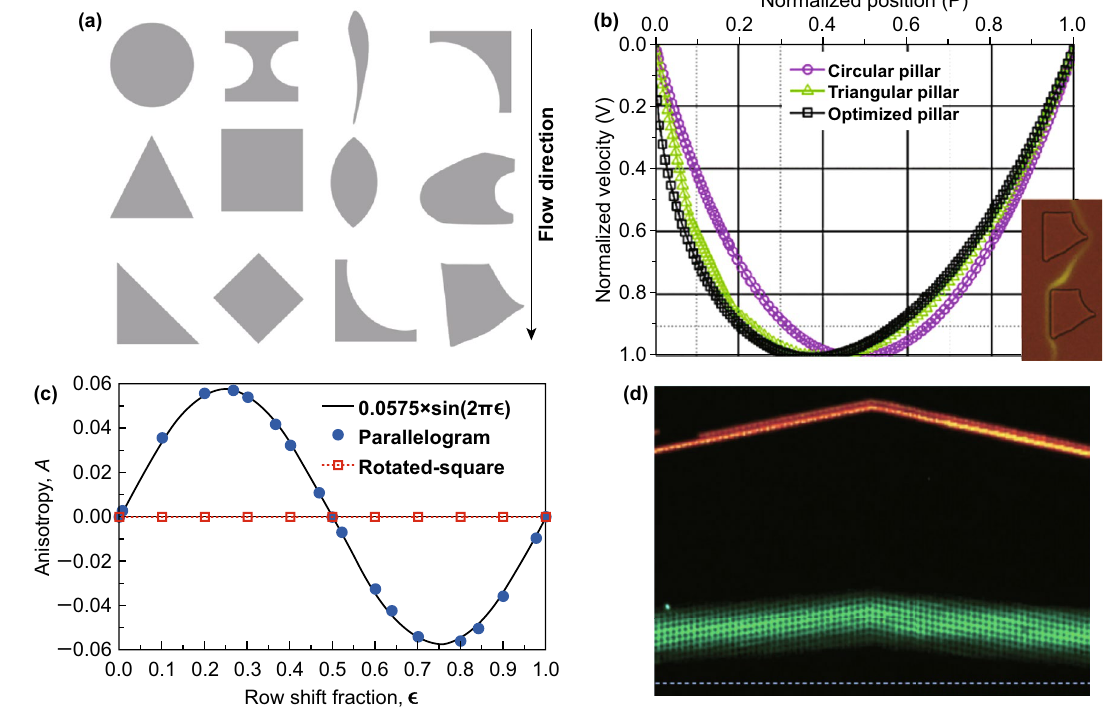
Fig. 5 Geometry-induced effects on critical diameter. a Various DLD pillar shape designs. b The effect of the optimized pillar structure on the velocity flow profile that changes the DLD critical diameter [42]. c Comparison of the anisotropic permeability values for the parallelogram and the rotated square array [29]. d The deviation of the green beads displacement trajectory at the enabler region due to the anisotropic permeability of the parallelogram array [29]. Figure panels reproduced from Ref. [42] with permission from Elsevier, copyright 2017, Ref. [29] with permis- sion from the Royal Society of Chemistry (CC BY